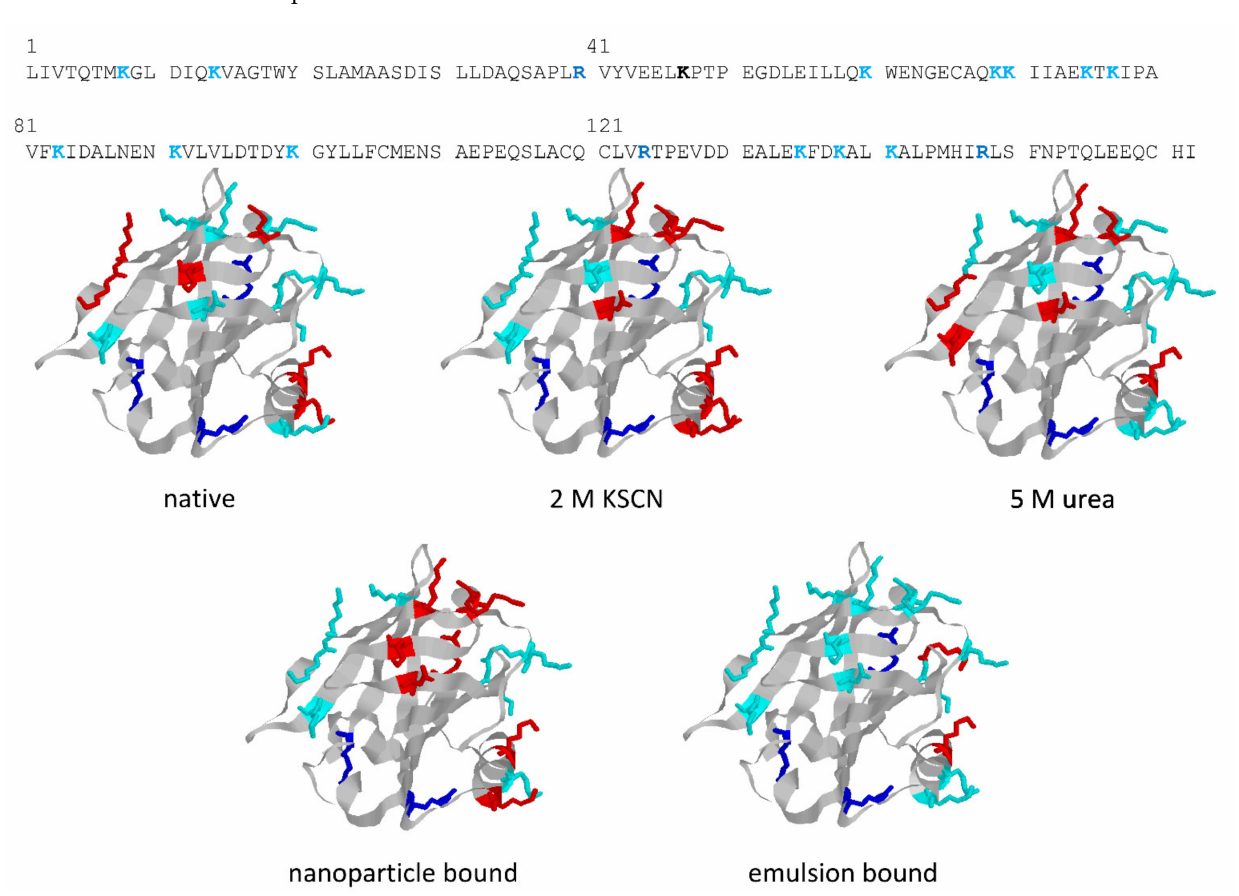
Figure 5. Action of trypsin on BLG conformers generated by different chemical or physical treatments. Sites of action of trypsin are highlighted in color (Lys, cyan; Arg, blue) in the sequence of BLG (top) and in the ribbon structures (all from the same view). Residues that are not accessible to trypsin hydrolysis upon protein unfolding in the given treatment conditions are in red. The sequence is from Uniprot (entry P02754), and crystallographic data are from PDB (entry 3UEU). Structures were built using the freeware Rasmol (rev. 2.7, www.OpenRasMol.org, accessed on 4 February 2022). Proteolysis data for the various conditions are from